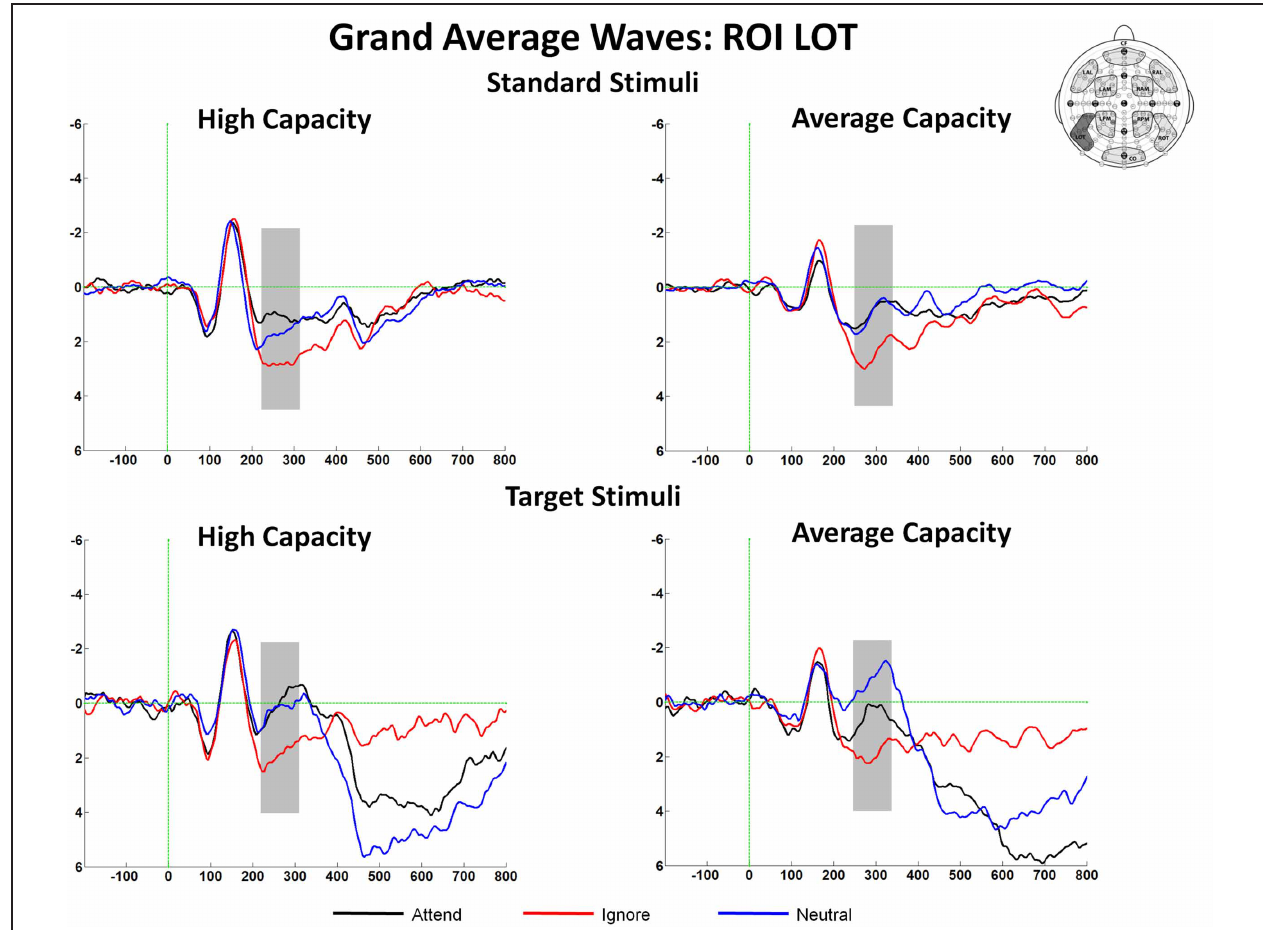
FIGURE 6 | Illustration of the differences between conditions at the left posterior ROI, LOT for high capacity and average capacity subjects in response to standard stimuli and target stimuli. The highlighted area represents the temporal interval in which the Selection Negativity (SN) was measured.